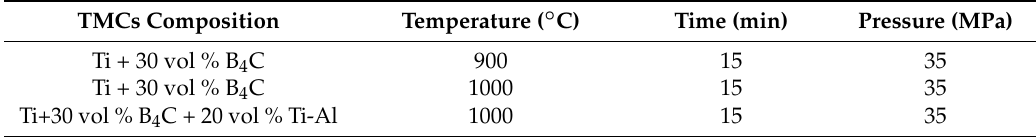
Table 1. In-situ TMCs (titanium matrix composites) processed at different manufacturing conditions. TMCs